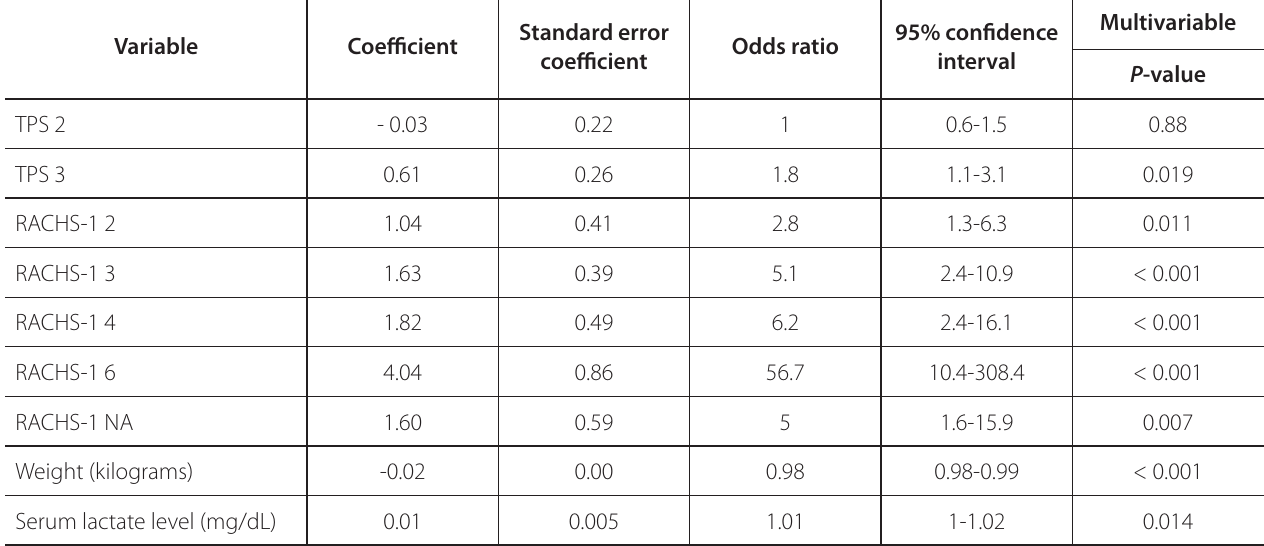
Table 5 . Postoperative complication risk factors — multivariable